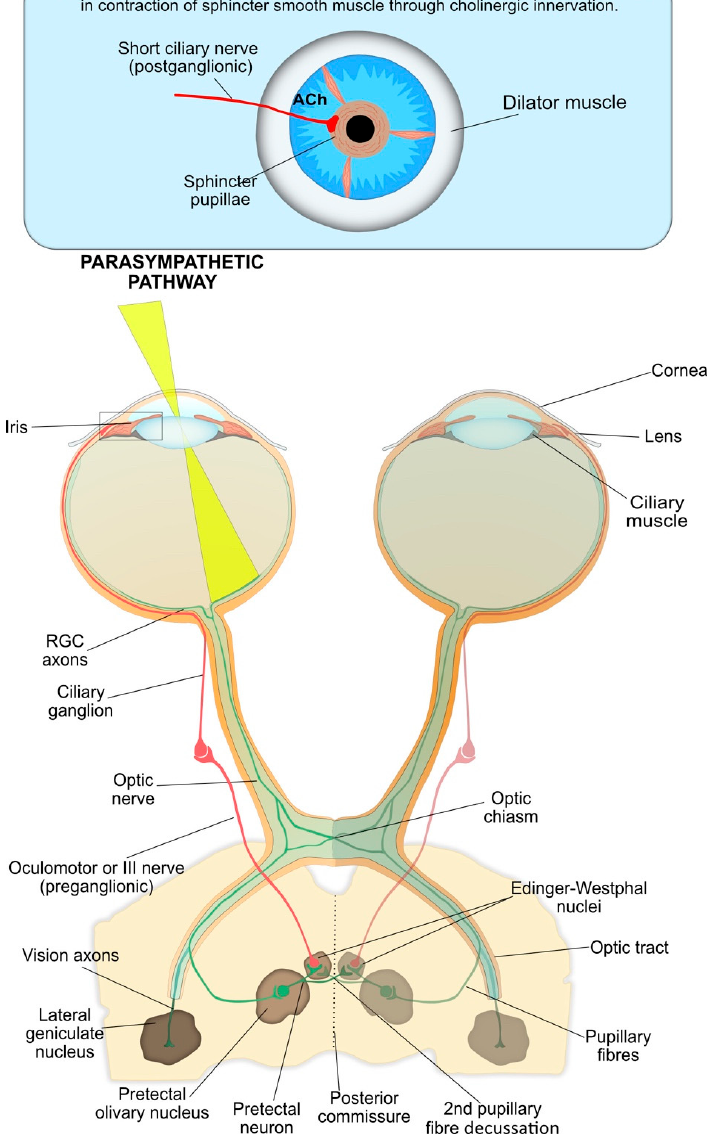
Figure 3. The parasympathetic nervous system is the main system responsible for pupil constriction in response to light. The integrated afferent input is transmitted along the axons of the retinal ganglion cells (RGC), which contribute to the optic nerve. At the optic chiasm, nerves from the nasal retina cross to the contralateral side, whilst nerves from the temporal retina continue ipsilaterally. The pupillary RGC axons exit the optic tract and synapse at the pretectal olivary nucleus. Pretectal neurons are projected either ipsilaterally or contralaterally, across the posterior commissure, to the Edinger-Westphal nucleus. From there, the pre-ganglionic parasympathetic fibres travel with the oculomotor, or III cranial nerve, and synapse at the ciliary ganglion. The post-ganglionic parasympathetic neurons (short ciliary nerves) travel to and innervate the contraction of the iris sphincter muscle via the release of acetylcholine at the neuromuscular junction, resulting in pupil constriction.